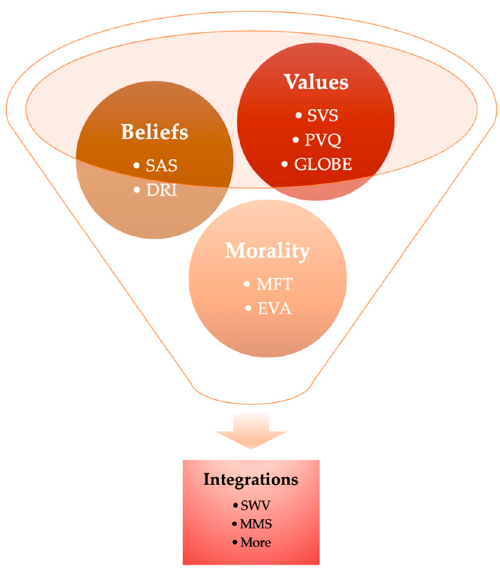
Figure 3. Visualization of attention to beliefs, values, morality and their integration in each study.